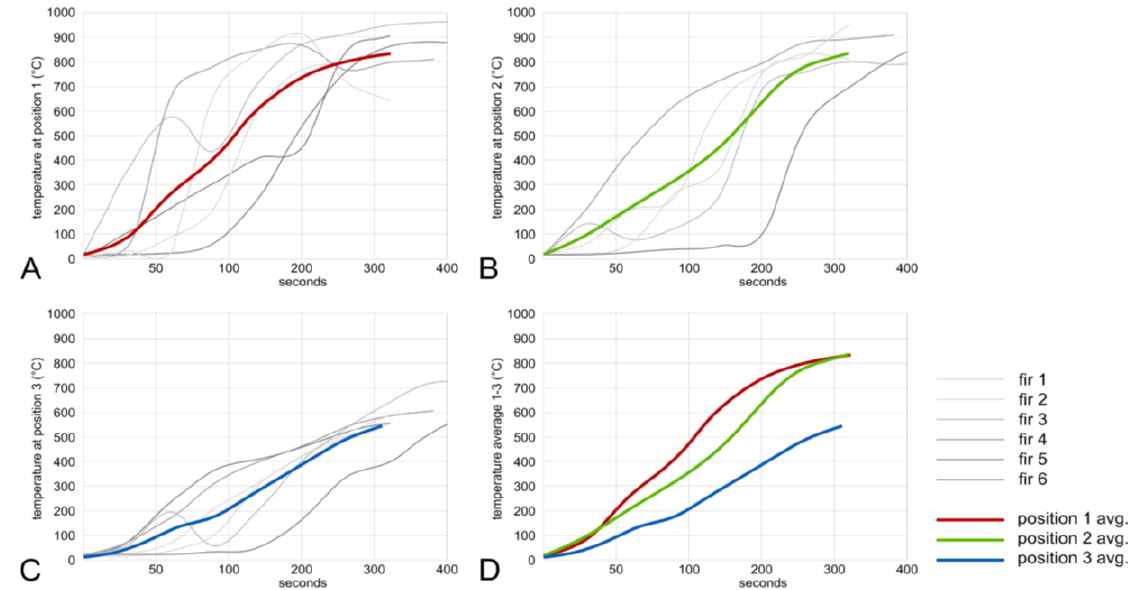
Figure 5. Temperature–time diagram for fir samples at positions 1, 2, and 3 ( A – C ) and average temperatures ( D ).